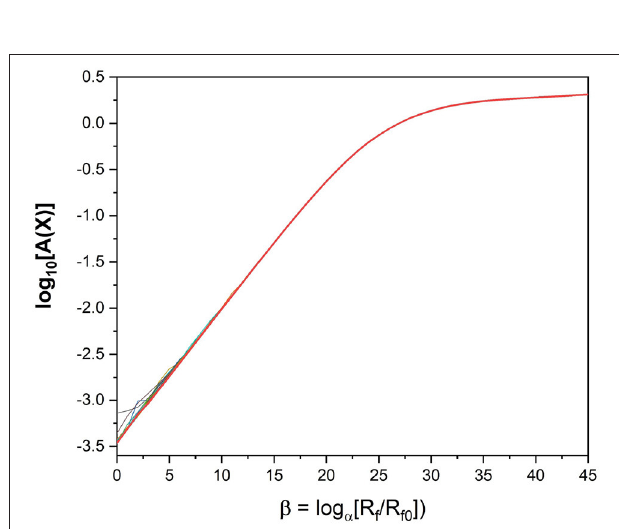
FIGURE 4 | Action Levels of the standard model action for the HVC X neuron model discussed in the text. We see that the action rises to a “plateau” where it becomes quite independent of R f . The calculation of the action uses PA with R m . N I α 1.4 and R f 0 100 initial choices for the path X init were used in = = = this calculation. For small R f one can see the slight differences in action level associated with local minima of A ( X ).